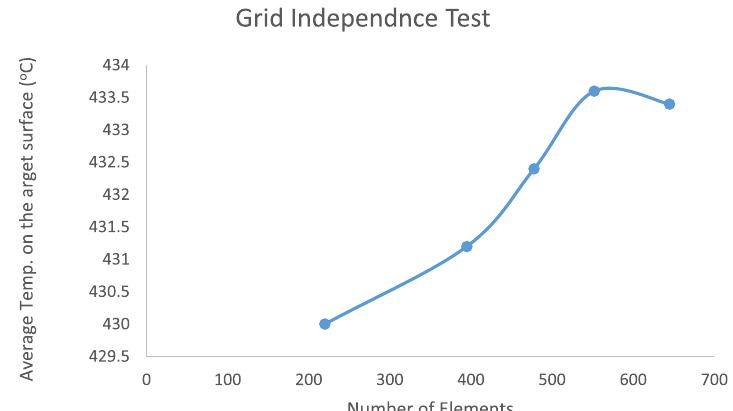
Fig. 5 Grid independence